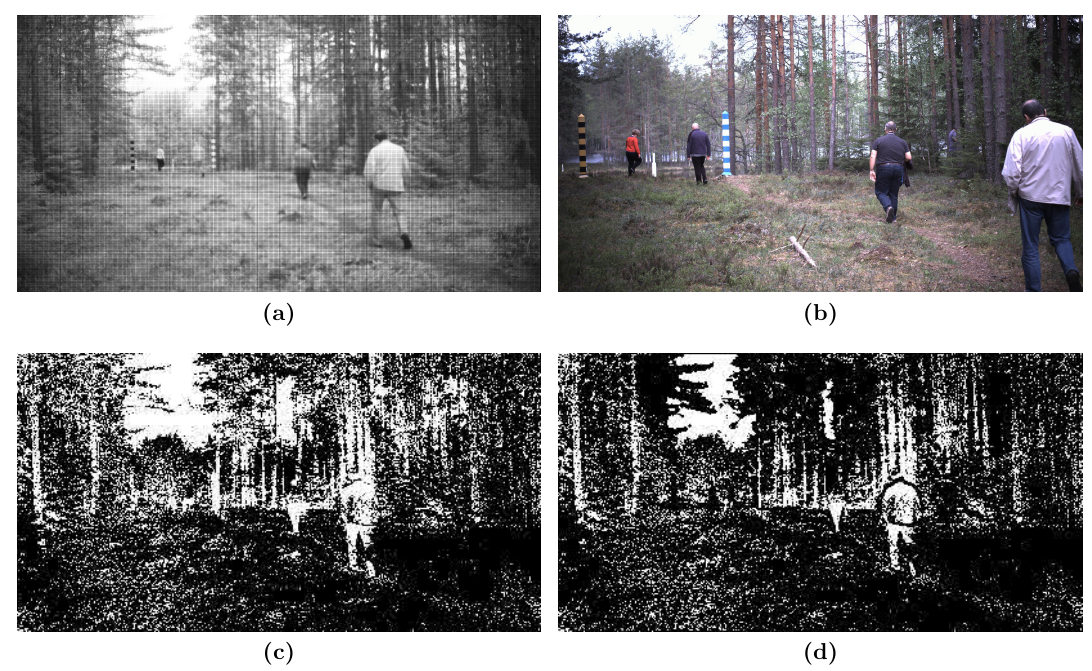
Figure 12. Terrestial scenario (Ground dataset), classification based on radiance: ( a ) Raw hyperspectral input frame. ( b ) Corresponding RGB frame. ( c , d ) Classification without and with spectral overlap supression, respectively. White: Classified as positive sample. Black: Classified as negative